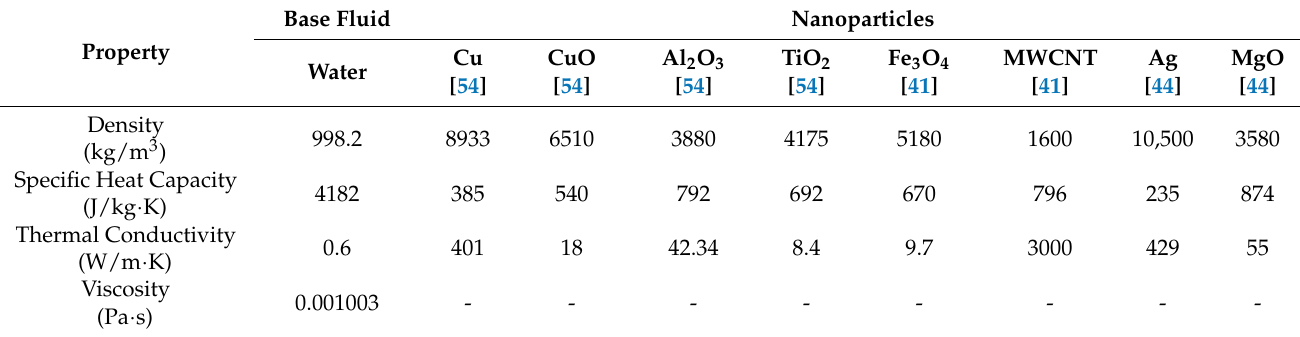
Table 3. Thermo-physical properties of base fluid and